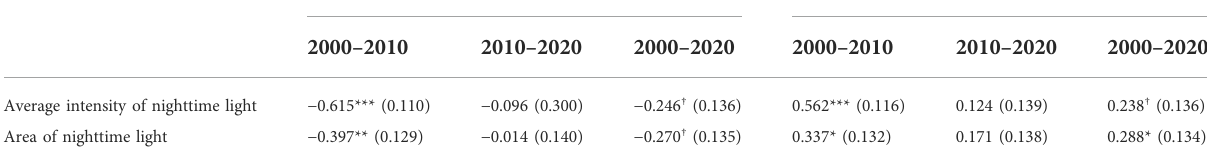
TABLE 4 Correlation between habitat fragmentation and nighttime light intensity and area. Dependent variables are changes in mean habitat patch size and number of habitat patches, respectively. Standardized coef fi cients and robust standard errors are reported outside and inside parentheses, respectively. Model results passed standard regression diagnostics. Variance in fl ation factors (VIFs) were tested to be <